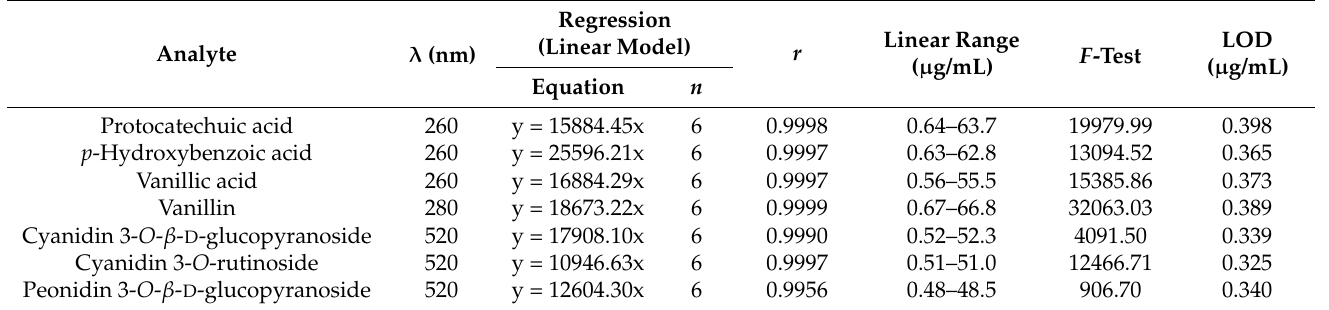
Table 3. Validation parameters for HPLC-PDA quantitative